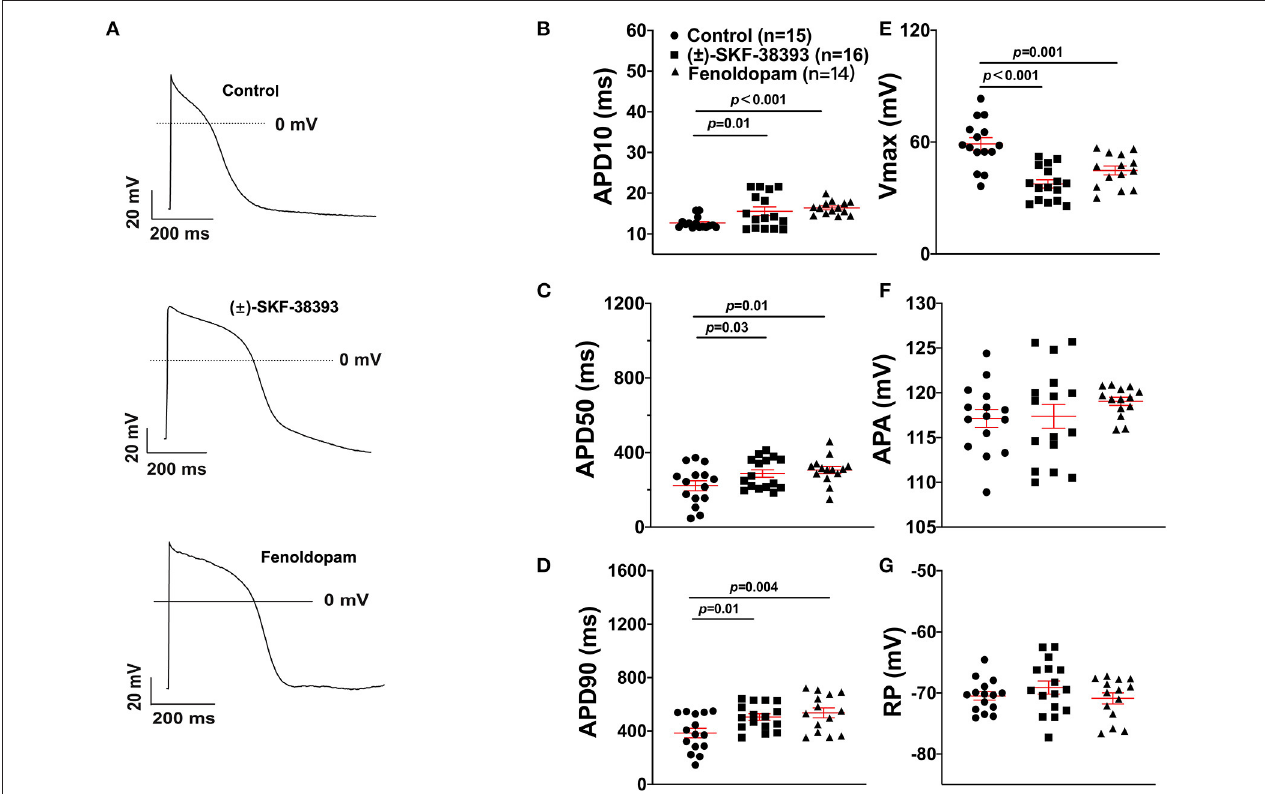
FIGURE 3 | Dopamine D1/D5 receptor agonists mimicked epinephrine effects on the action potential (AP). hiPSC-CMs were challenged by either vehicle (Control) or 50 µ M ( ± )-SKF 38393 or 5 µ M fenoldopam for 1h and action potentials (APs) were recorded. (A) Examples of AP traces in each group cells. (B) Mean values of APD10 in each group cells. (C) Mean values of APD50 in each group cells. (D) Mean values of APD90 in each group cells. (E) Mean values of AP Vmax in each group cells. (F) Mean values of AP amplitude (APA) in each group cells. (G) Mean values of resting potential (RP) in each group cells. “ n ” numbers in (B) are for (B–G) . The p -values vs. Control were determined by the analysis of one-way ANOVA with Holm-Sidak